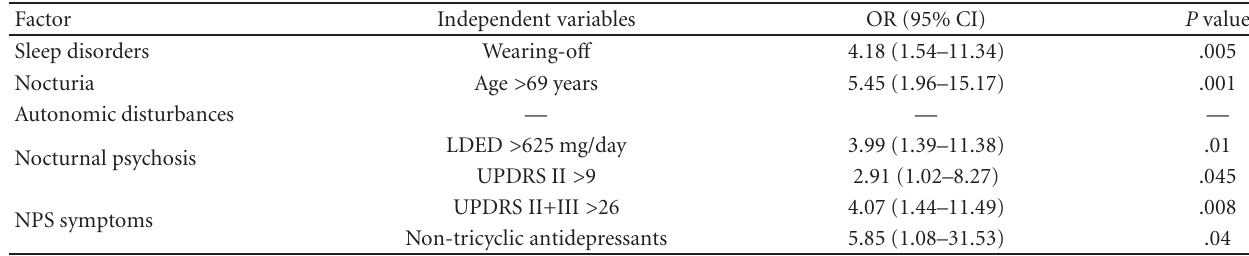
Table 3: Variables independently related to categorized factor